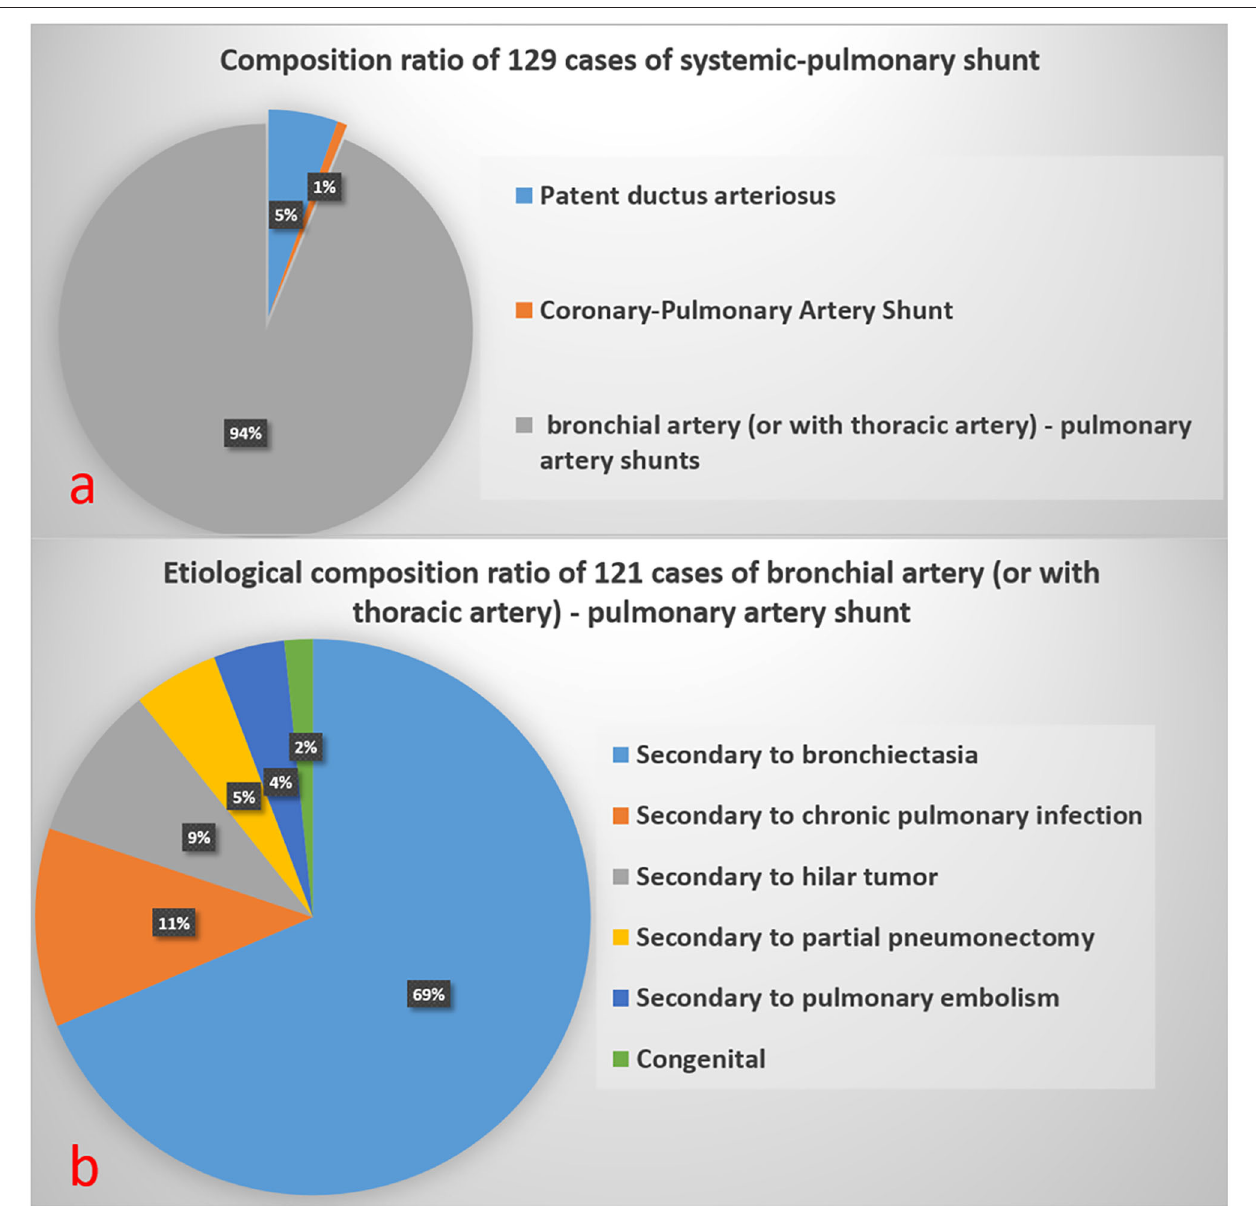
FIGURE 5 | Composition ratio of 129 Systemic-Pulmonary Shunt Artifacts in (a) . Etiological composition ratio of 121 cases of bronchial artery (or with thoracic artery)-pulmonary artery shunt in (b)